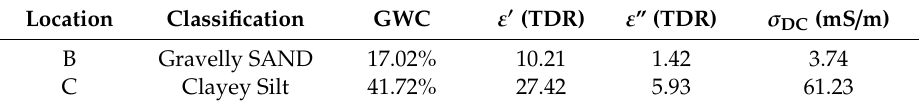
Figure 9. Schematic of the RF (Radio Frequency) trials from literature [23]. Table 4. Soil characteristics of location B and C.